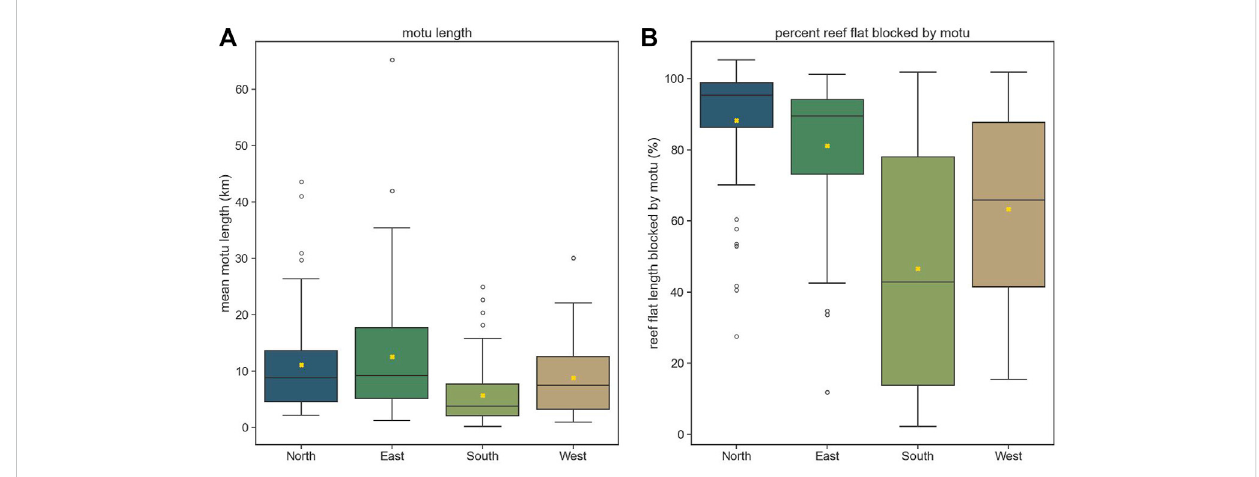
FIGURE 6 (A) Binned cardinally per-atoll total motu length for French Polynesia (n = 231). (B) Percent of total length of reef fl at covered by motu separated by cardinal bin, yellow x marks mean values of distribution of data.